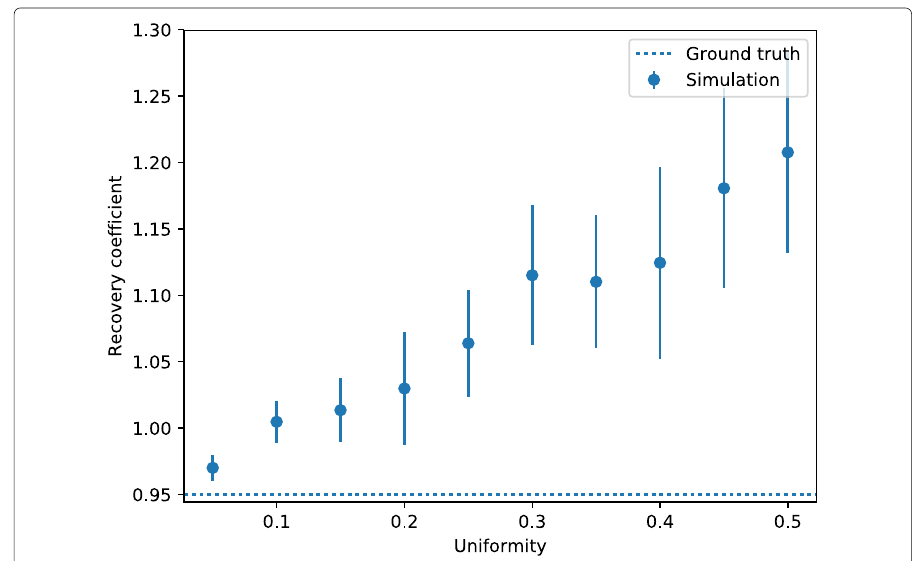
Fig. 6 Simulated recovery coefficient of the 5-mm rod as a function of the uniformity. The ground truth for the recovery was 0.95. The simulated recovery coefficients are always larger than the ground truth and increase with increasing variance (i.e., larger uniformity